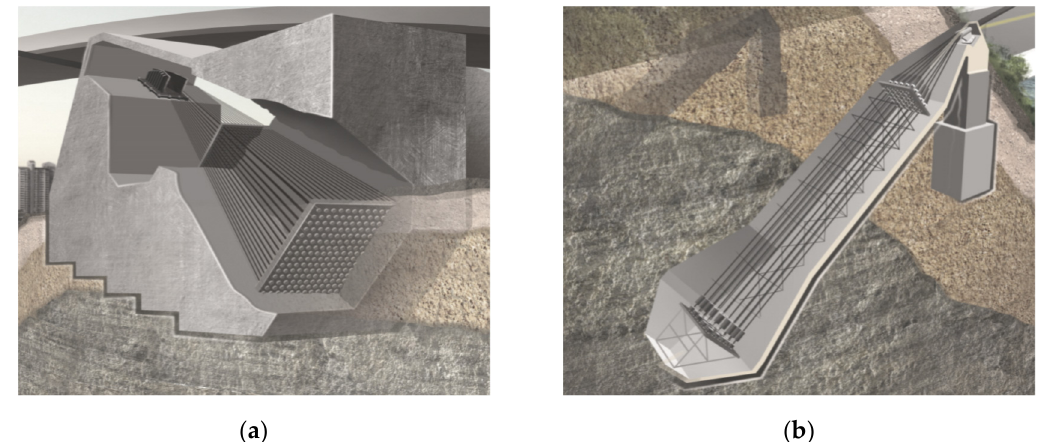
Figure 1. Typical types of anchorages: ( a ) gravity-type and ( b ) tunnel-type.